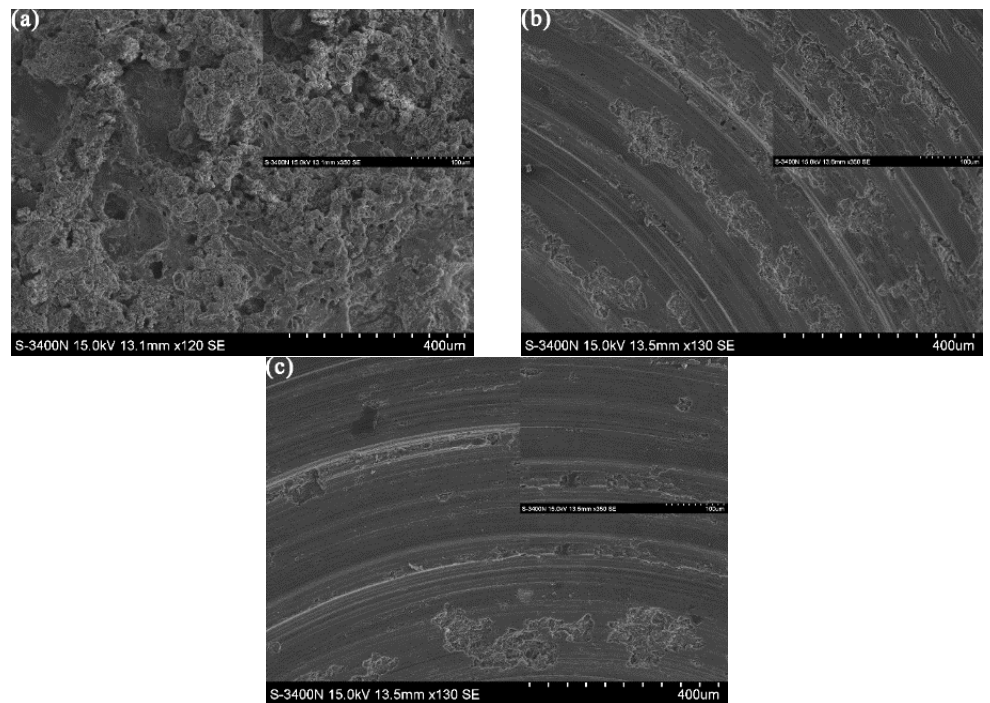
Figure 13: SEM photographs of machined surface: (a) Produced by non-abrasive round electrode; (b) Produced by abrasive round electrode; (c) Produced by abrasive shaped